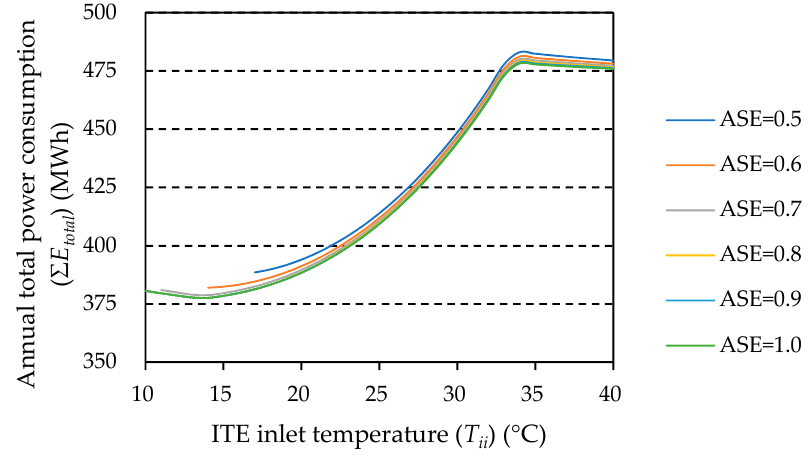
Figure 22. Annual total energy consumption ( Σ E total ) versus ITE inlet temperature ( T ii ).